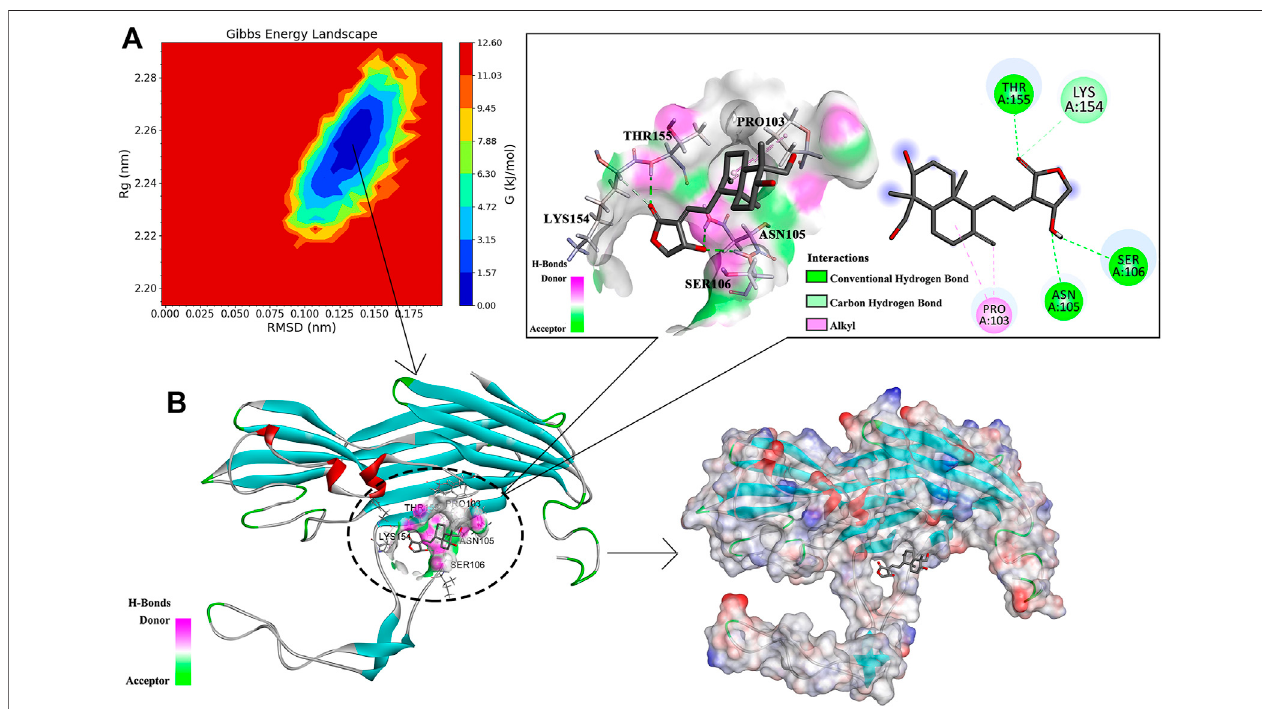
FIGURE 8 | Free energy topography of the Hla – AP complex and its stable conformation. Note: (A) is the free energy topography of the Hla – AP complex; (B) is the stable conformation of the Hla – AP complex.